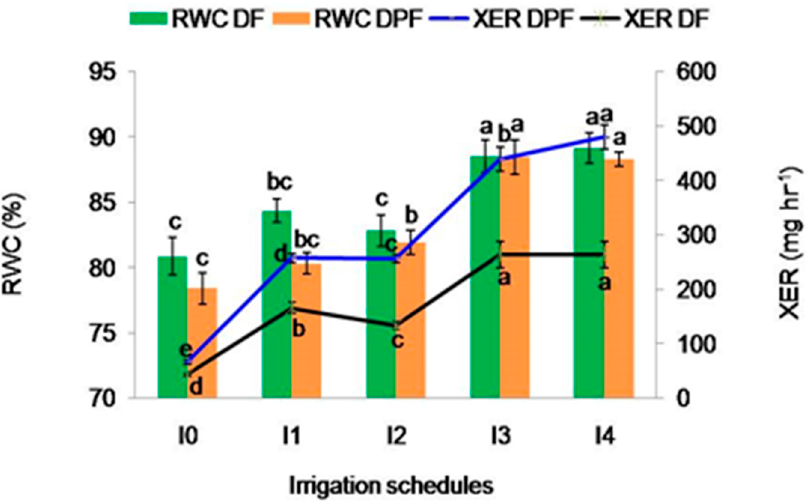
Figure 2. Water status (RWC and XER) under different irrigation schedules at the DF and DPF stages (Data followed by the same letter are not differed significantly by LSD test at p < 0.05)